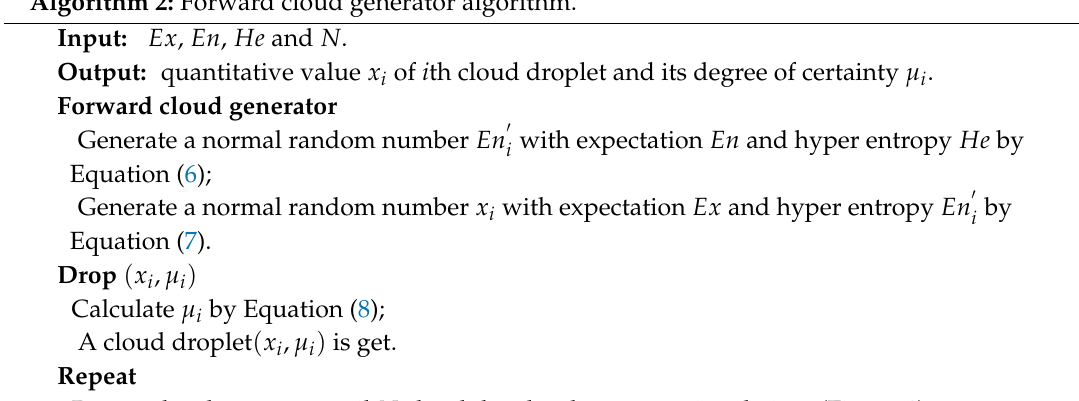
Algorithm 2: Forward cloud generator algorithm.